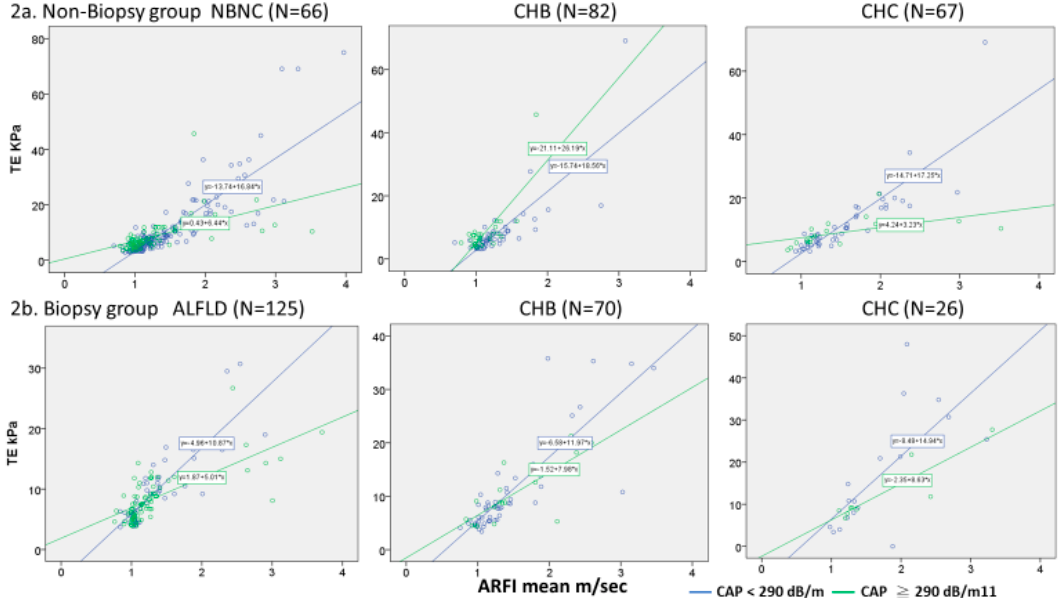
Figure 2. Correlation between Tranient elastography (TE) and Acoustic radiation force impulse (ARFI) fibrosis measurements in the various control attenuation parameter (CAP) and etiology groups. ( a ) The correlations between the high and low CAP groups di ff ered significantly in all etiology groups ( p < 0.001). A similar pattern of lower measurements of TE liver sti ff ness in the high CAP group versus the low CAP group was found in non-B / non-C liver cirrhosis (NBNC) and chronic hepatitis C (CHC) patients. Paradoxically, higher TE liver sti ff ness measurements were recorded in the high CAP patients than in the low CAP patients among those with CHB. ( b ) Similar correlation patterns were noted in the biopsy group for each etiology subgroup with a smaller di ff erence between high CAP verse low CAP group in those with CHB. Table 3. ( a ) CAP grades and fibrosis measurements of NAFLD and CHC patients by di ff erent modalities; ( b ) CAP grades and fibrosis measurements of CHB patients by di ff erent